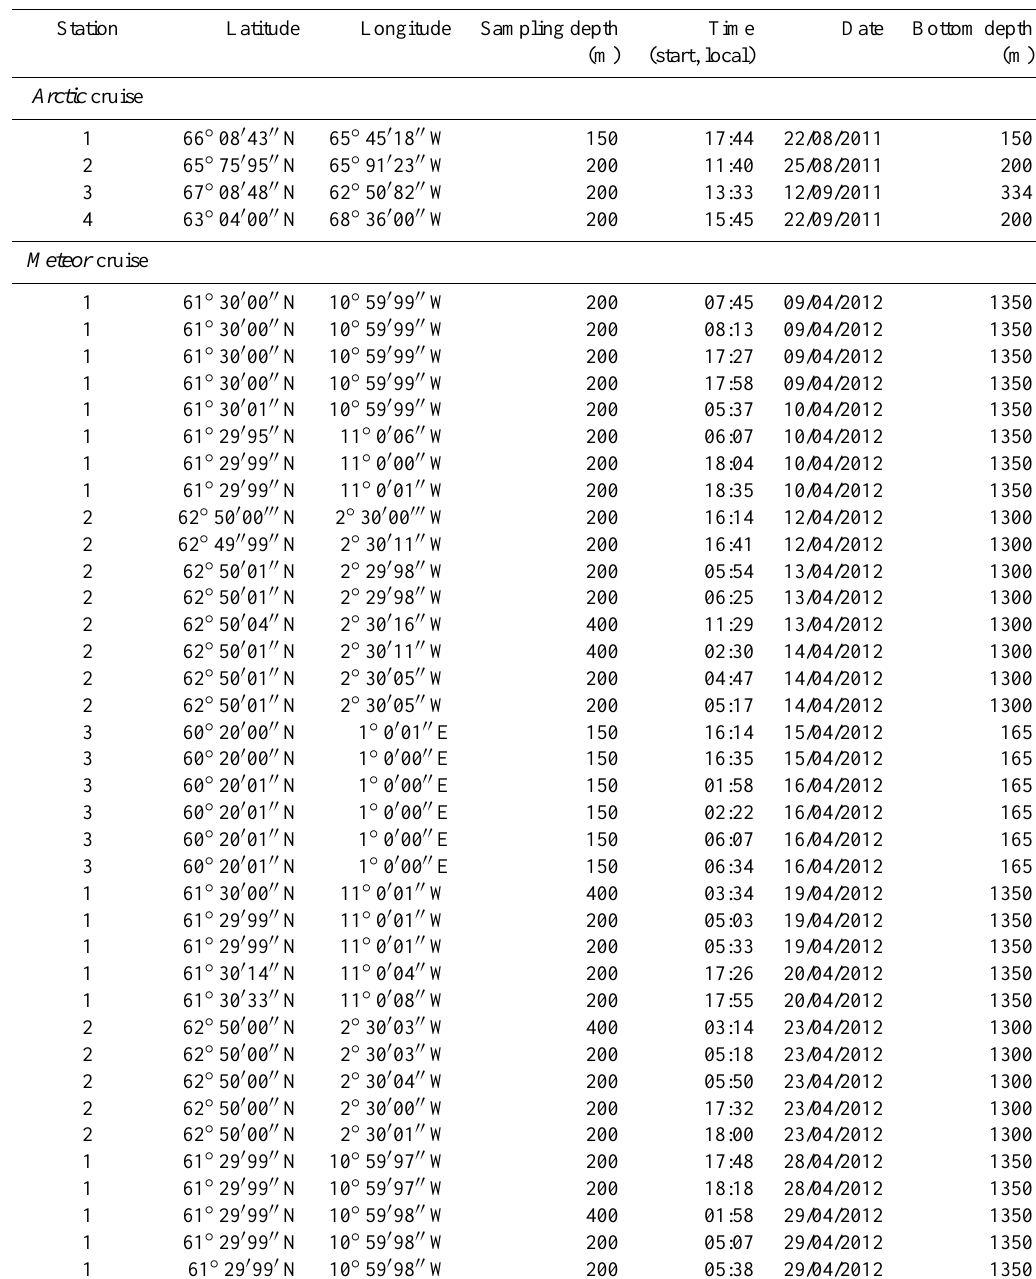
Table 2. List of stations in which jellyfish were collected using the Jellynet. Main sampling information is also indicated. Data from Licandro and Blackett (2014), Licandro and Hosia (2014), Licandro and Kennedy (2014), Licandro and Raab (2014) and Licandro et al. (2014).